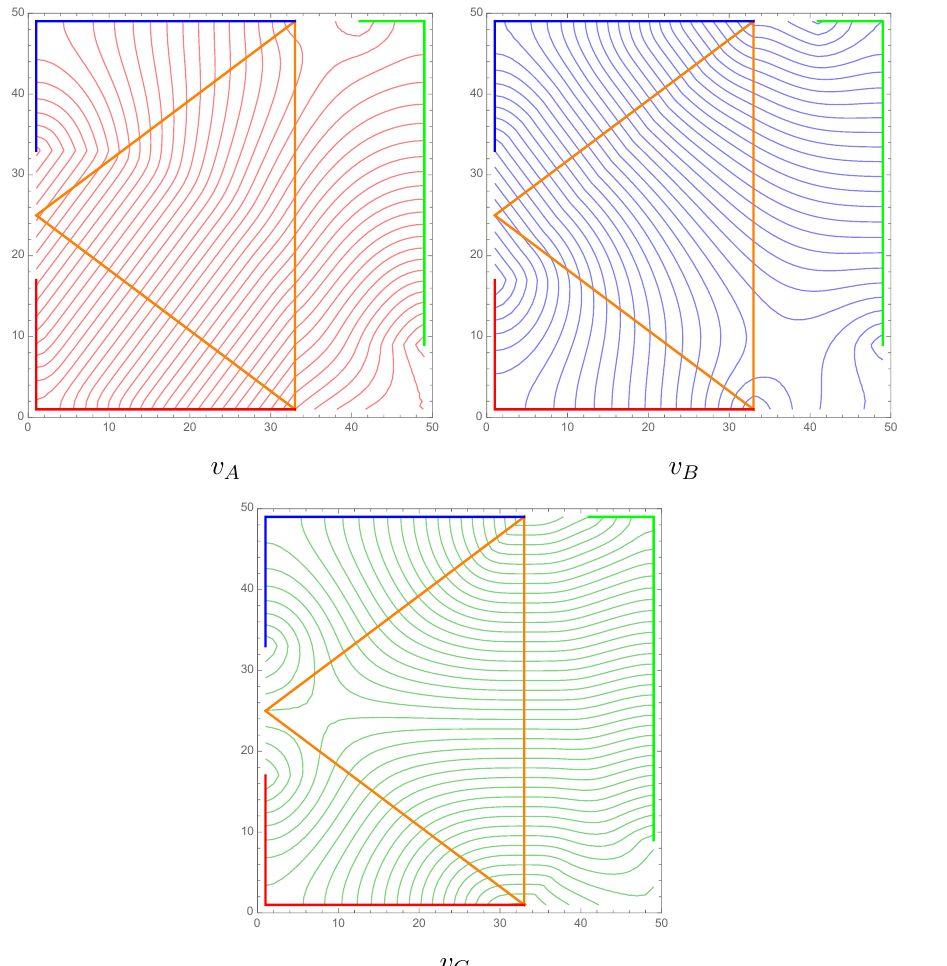
Figure 16 . An example of maximal (cid:13)ows for a choice of boundary regions A; B; C on a (cid:13)at V square. The region A is in red, B in blue, and C in green. The minimal surface (cid:6) is given by the orange triangle. The (cid:13)ows was calculated by latticizing the manifold and using Mathematica ’s built in FindMaximum